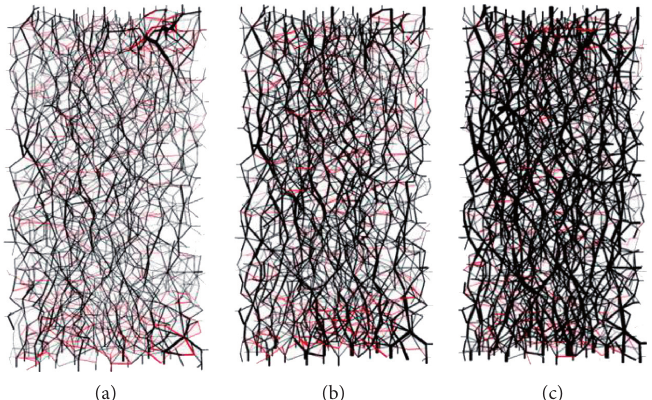
Figure 7: Contact force chains of discrete element samples at w � 6.9% and f � 1Hz affected by deviatoric stress amplitude. (a) σ � 45 kPa. (c) σ � 60 (b) σ 0 0